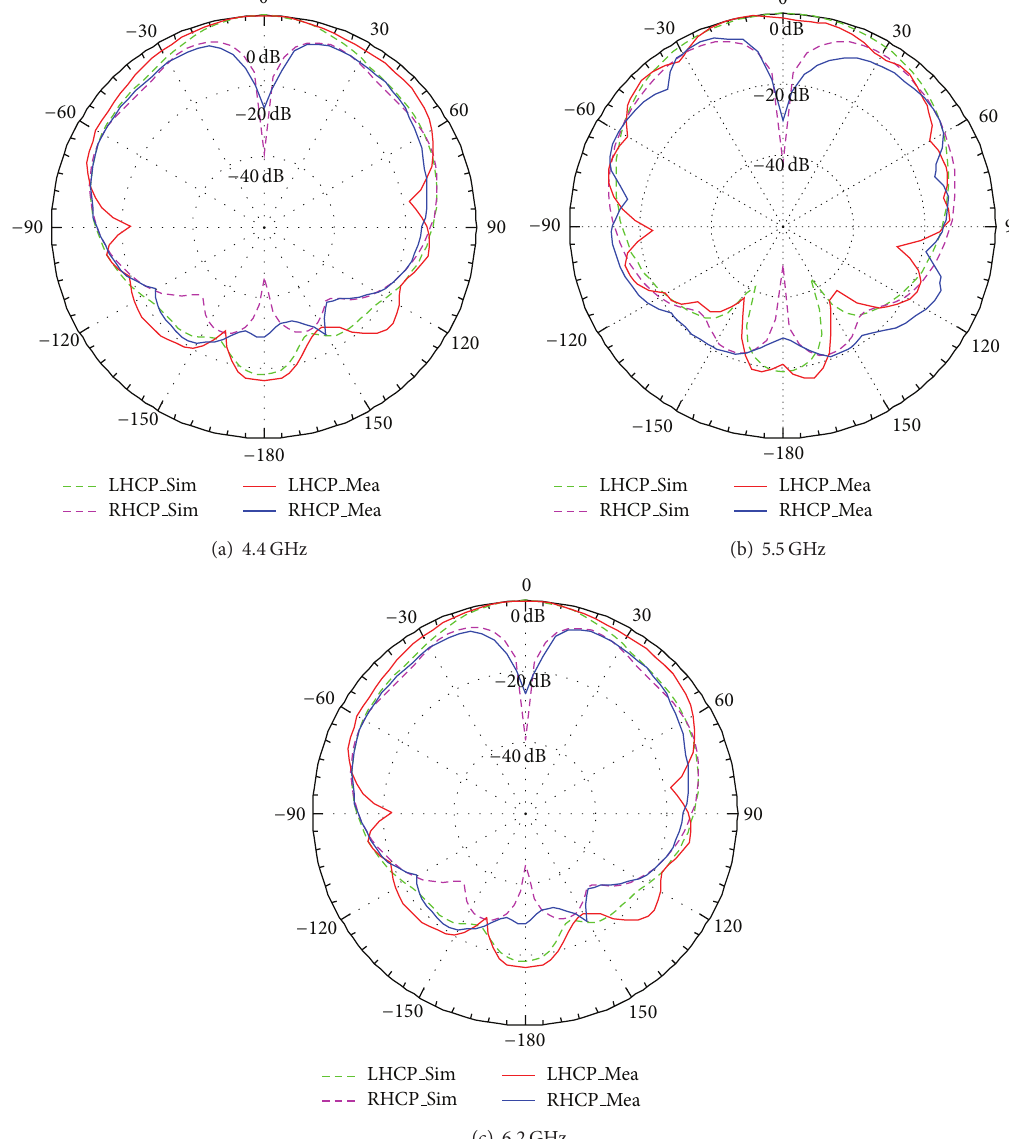
Finally, at 6.6 GHz all the metallic surfaces of the antenna are affected by the surface current as it appears from Figure